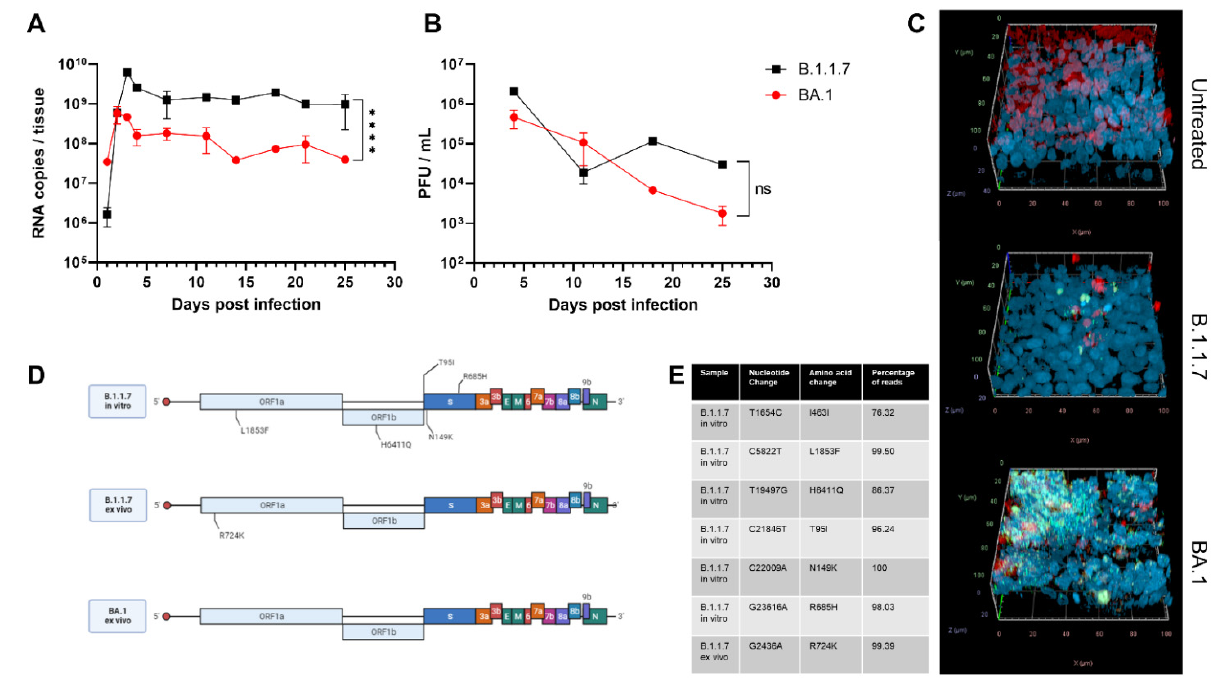
Figure 1. Evolution of SARS-CoV-2 variants ex vivo and in vitro after 25 days of infection. MucilAir tissues were infected with Alpha (B.1.1.7) or Omicron (BA.1) SARS-CoV-2. For 25 days, tissues were maintained at 33 ◦ C and apical washes were performed to collect released SARS-CoV-2 viruses, quantified by RT-qPCR ( A ) and plaque assay ( B ). ( C ) Tissues were fixed and stained with J2 (dsRNA: green), β -tubulin IV (ciliated cells: red), and DAPI (nuclei: blue) at the end of infection. ( D ) Viruses were deep-sequenced at the end of infection ex vivo or after 11 passages in Vero E6. Mutations that were not present in the original sample are shown (created with biorender.com). ( E ) Nucleotide changes and percentage of reads present in the different samples. The results are the mean and SEM of two (B.1.1.7) or three (BA.1) MucilAir. p -value < 0.0001 (****).